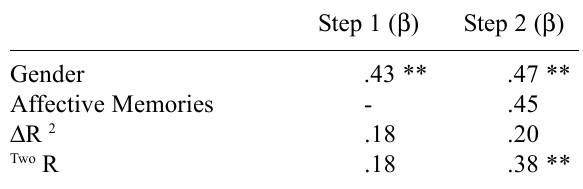
Linear Regression: Total